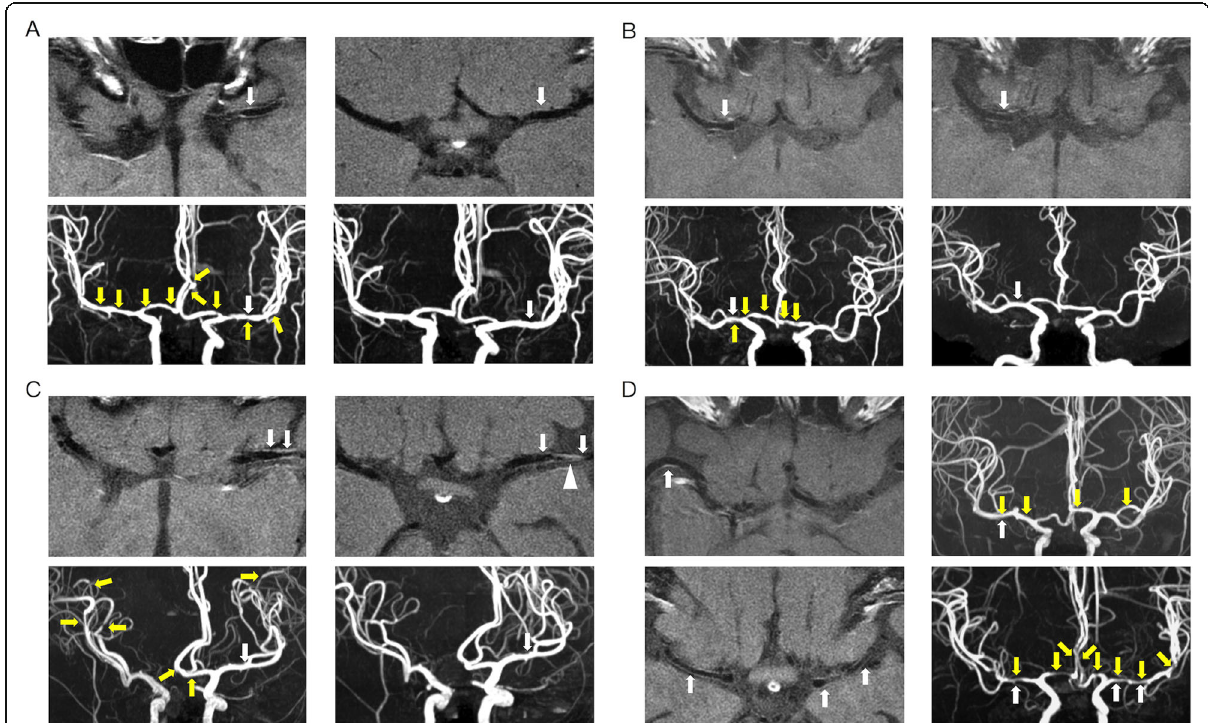
Fig. 1 Vascular wall enhancement in patients with RCVS. a , initially mild concentric enhancement, vascular imaging obtained 10 days after disease onset in a 48-year-old female; the enhancement was completely resolved at 7 years of follow-up; b , initially mild concentric enhancement, vascular imaging obtained 9 days after disease onset in a 52-year-old female; the enhancement was partially resolved 96 days later; c , initially marked concentric enhancement, vascular imaging obtained 10 days after disease onset in a 60-year-old female; the enhancement was partially resolved at 4.5 years of follow-up. The white arrowhead in c indicates partial volume of vein. Note that the enhanced vascular wall did not concordantly present at the site of vasoconstriction; d , upper, initially mild eccentric enhancement, vascular imaging obtained 25 days after disease onset in a 49-year-old female; lower, initially mild concentric enhancement, vascular imaging obtained 15 days after disease onset in a 48-year-old female. White arrows locate vascular wall enhancement. Yellow arrows locate